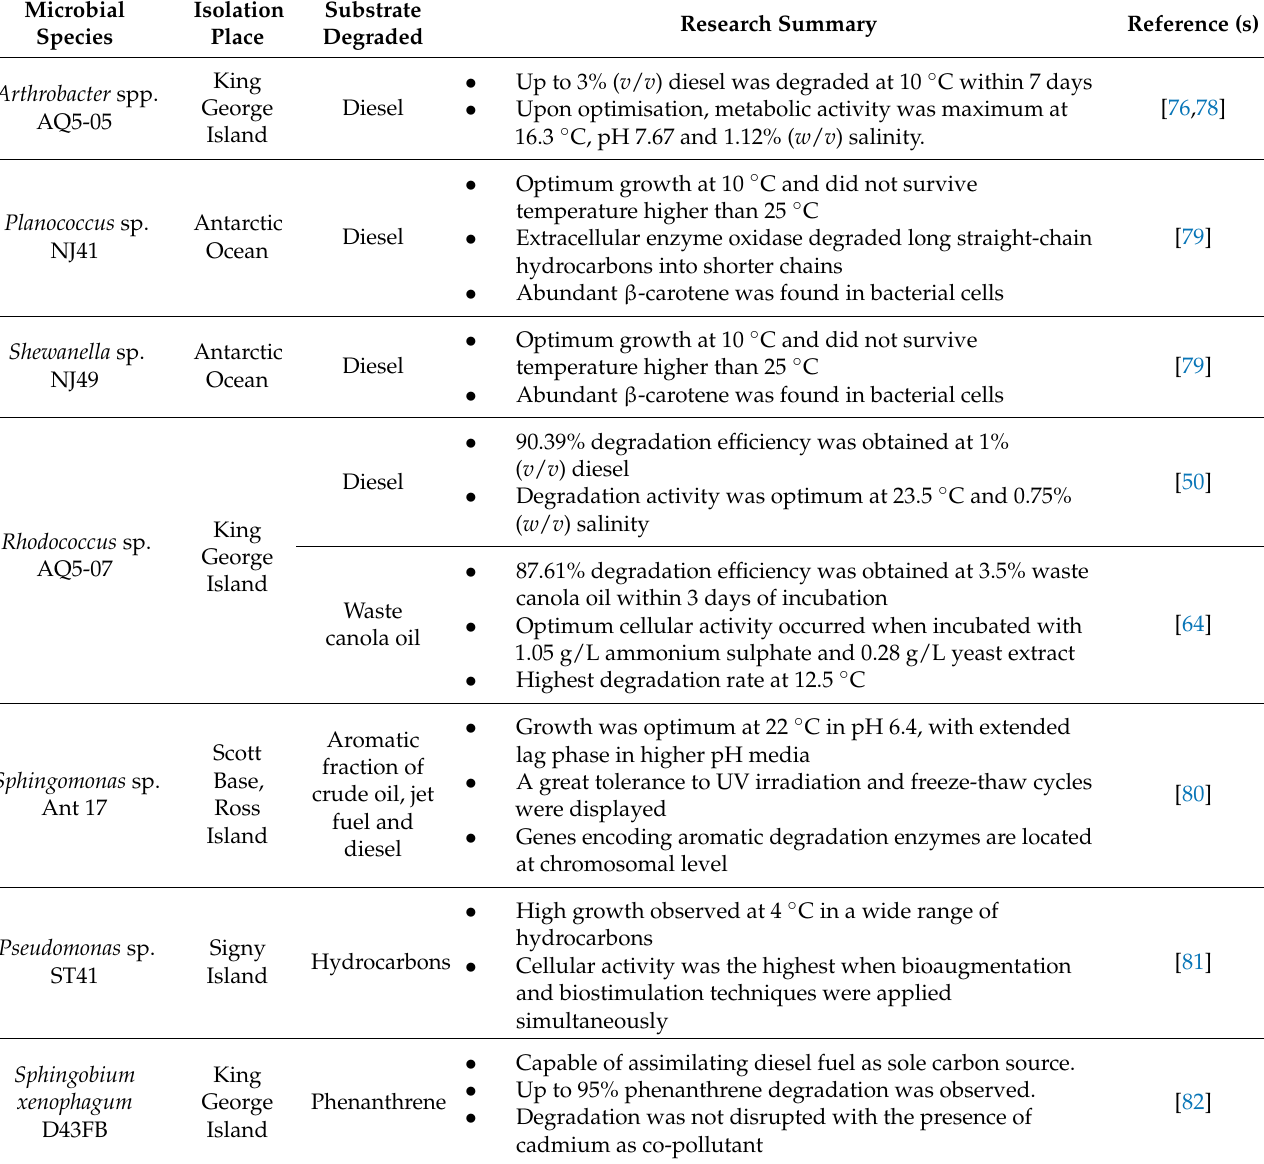
Table 3. Hydrocarbon-degrading bacterial species isolated from